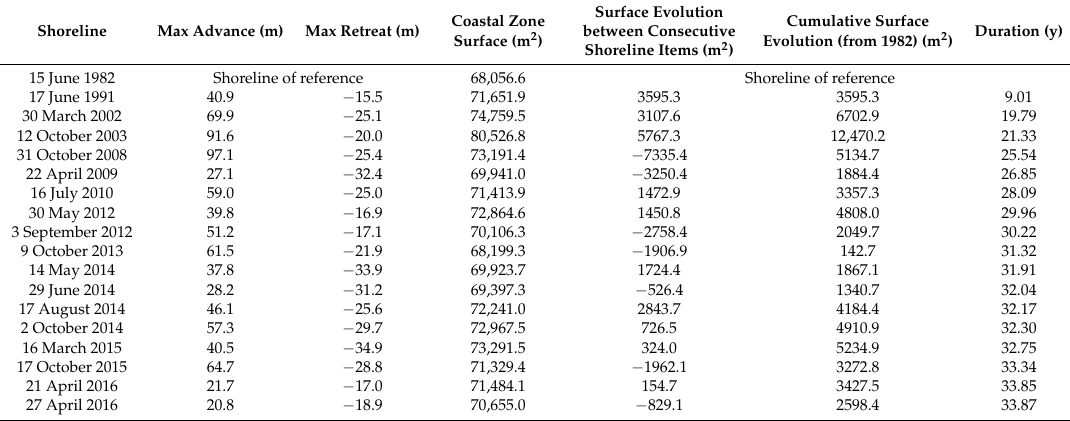
Table 3. DSAS results of shoreline displacement